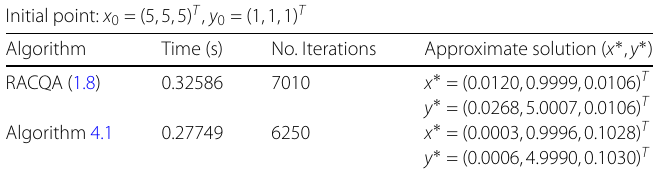
Table 2 Numerical results of Example